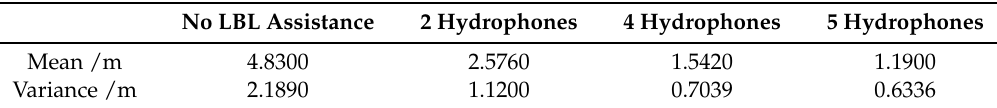
Figure 9. Errors of SINS/LBL tightly coupled algorithm. Table 3. Position errors of SINS/LBL tightly coupled algorithm.